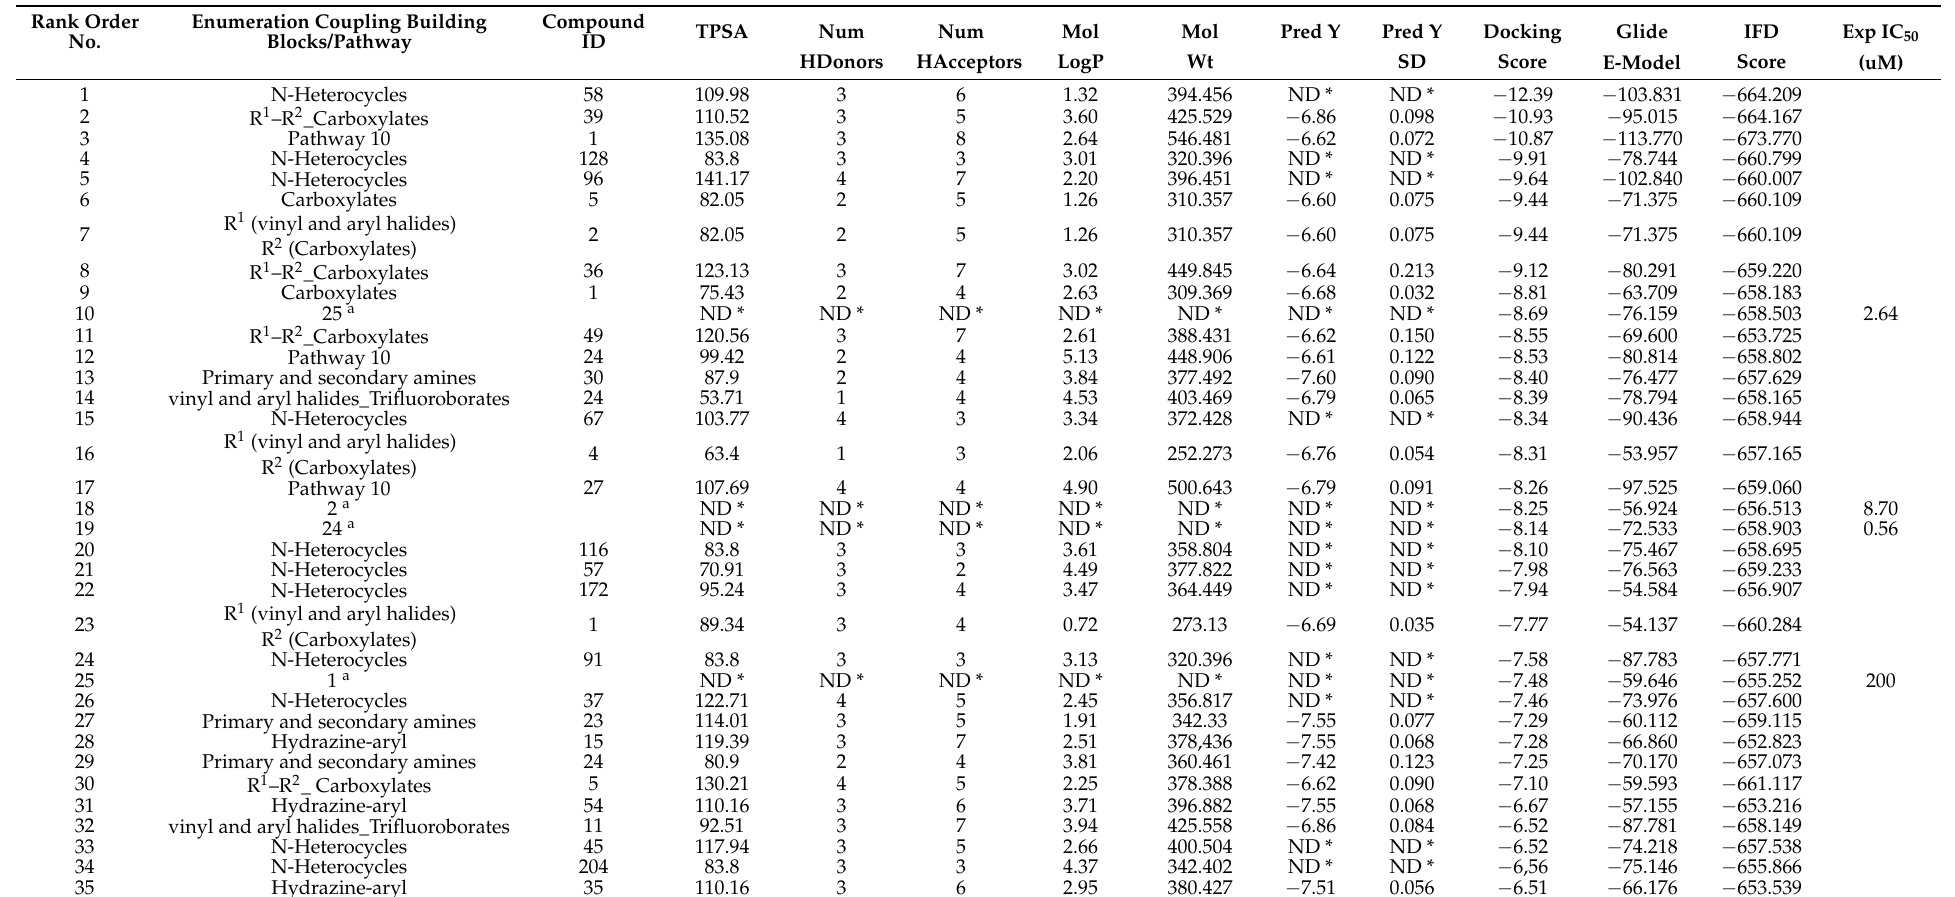
Table 2. Physicochemical parameters simulated during model building of the design ideas including positive control inhibitors from the literature with their predicted docking scores obtained using Auto QSAR_model_10 and their associated IFD binding affinity parameters. Rank Order